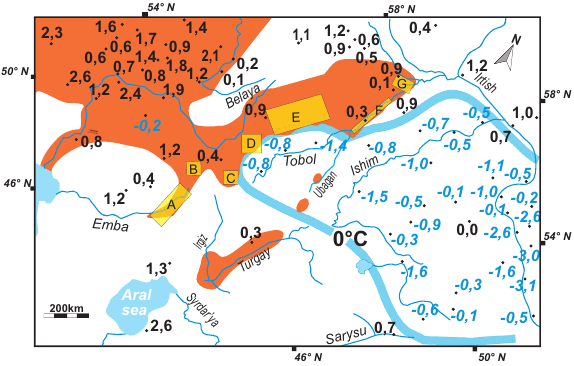
Figure 3. Soil temperatures of the coldest month to the east of range of the Pallas’ spadefoot. Average soil temperatures of the coldest month at a depth of 160 cm in the eastern part of the geographic range of the Pallas’ spadefoot (shaded). Numbers represent temperature (°C); wide blue line – isotherm (0 °C). Rectangles with letters – the territories with the easternmost points of spadefoot’s finding (excluding enclaves). Names and coordinates of these points – in (Suppl. material 1: Table